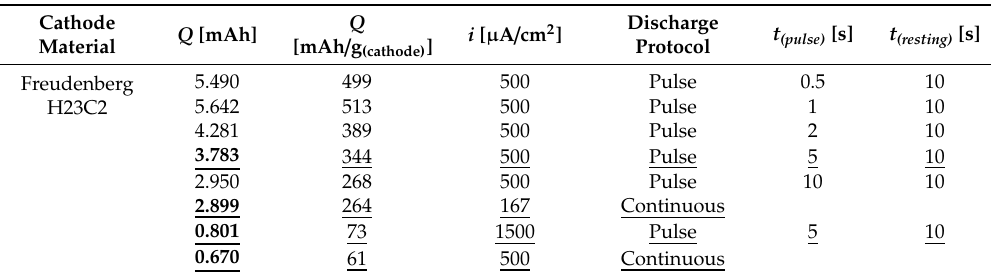
Table 1. Summary of the pulse discharge experiments with Freudenberg H23C2 used as Table 2. For direct comparison, continuous discharging experiments that would be used in a three-battery parallel circuit setup are highlighted in bold.